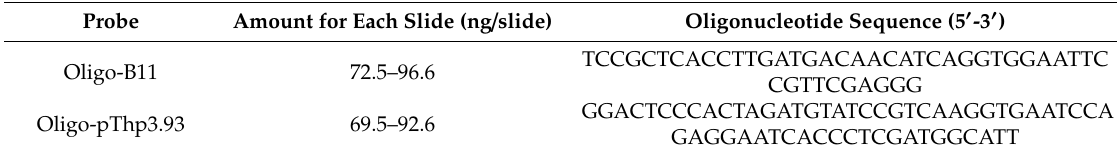
Table 1. Oligonucleotide sequences of new oligo probes developed in this study.